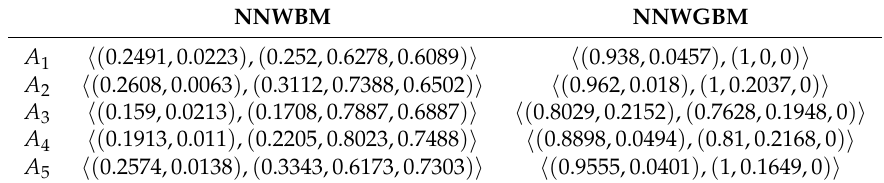
Table 12. Liu and Li’s method [6] (the NNWBM operator and NNWGBM operator p = 10, q = 10).